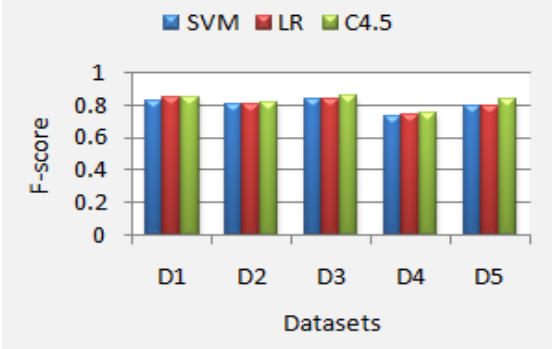
Figure 2. Prediction results of machine learning techniques in terms of F-Score for different datasets based on temporal, spatial and data-centric social contexts.